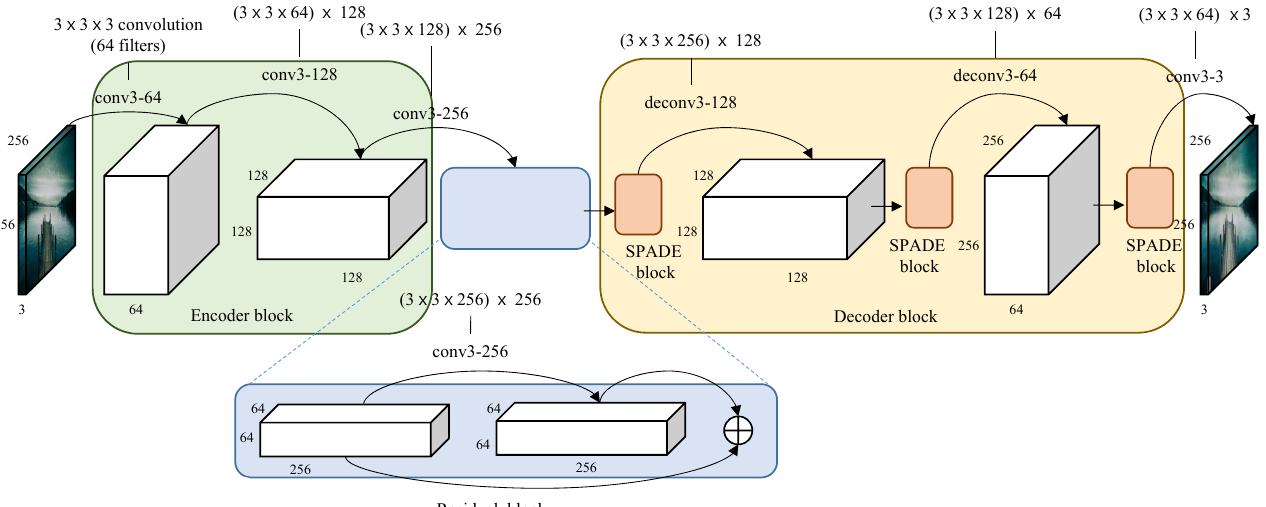
Figure 2. The architecture of our generator: An encoding block, a residual block and a decoder block is aligned. In the decoder block, we place three SPADE blocks to properly process the region